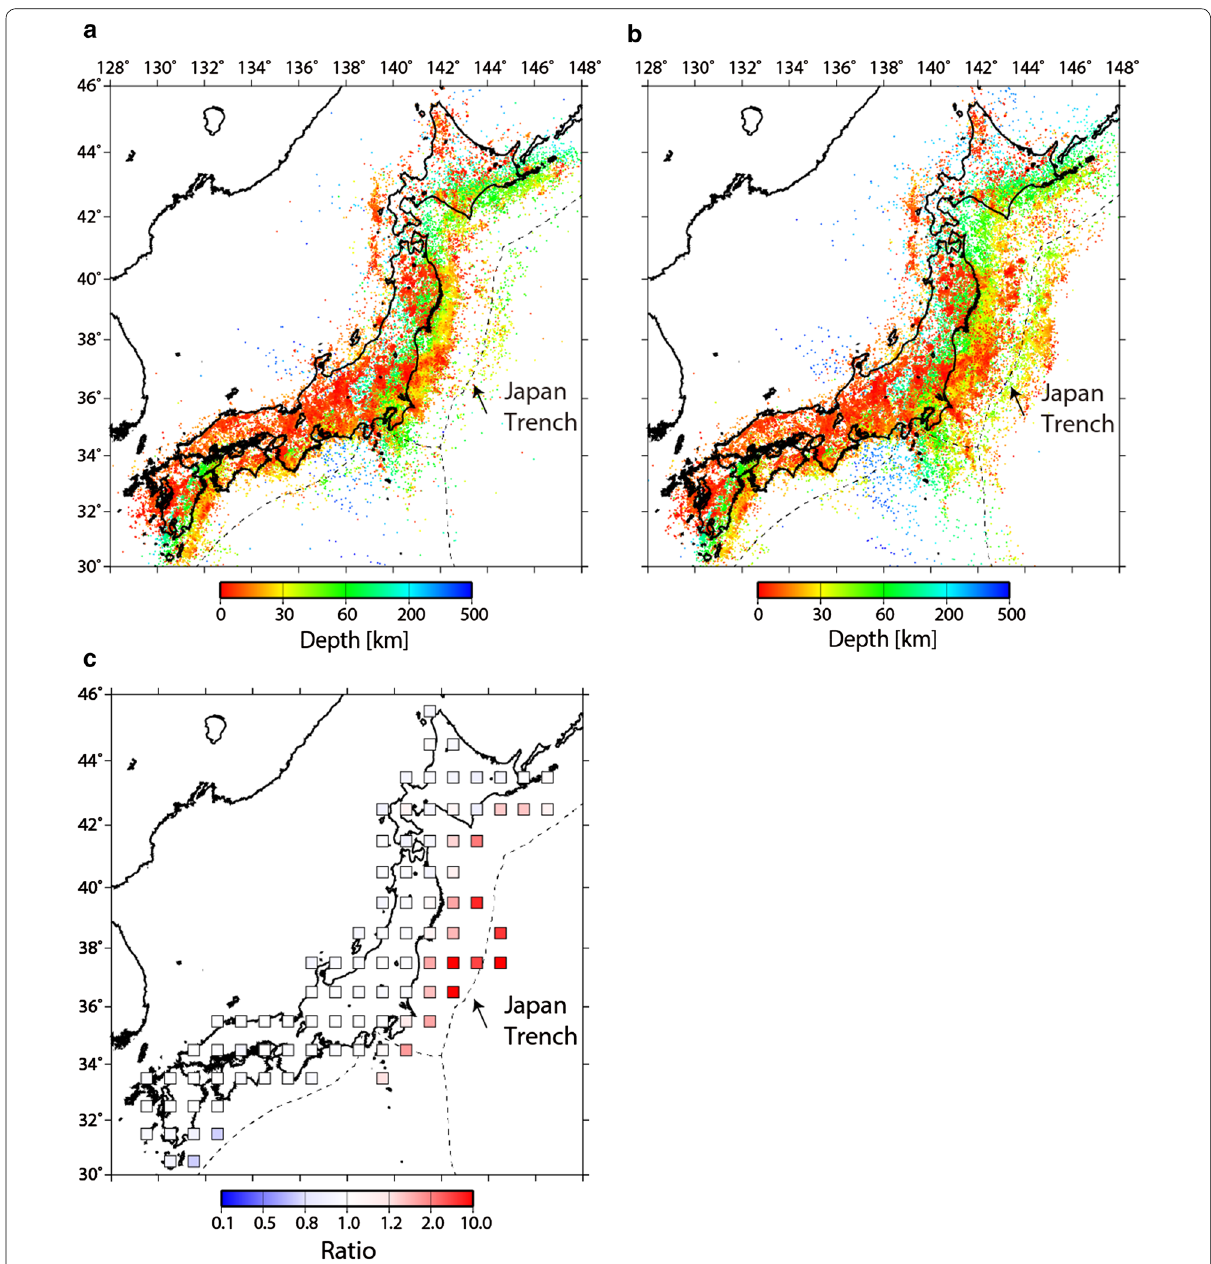
Fig. 11 Distribution of hypocenters estimated from a Dataset 1, b Dataset 2, and c the number ratio of events from Dataset 2 to those from Dataset 1. In a and b , the dots denote estimated hypocenters. The color indicates the depth of the hypocenters. In c , the number ratio was estimated from numbers of earthquakes shallower than 60 km within each one-degree bin for both datasets using 100 events for both datasets. The evaluated number ratios are plotted as the colored squares in the center locations of these bins. The color used for the number ratio is shown below ( c